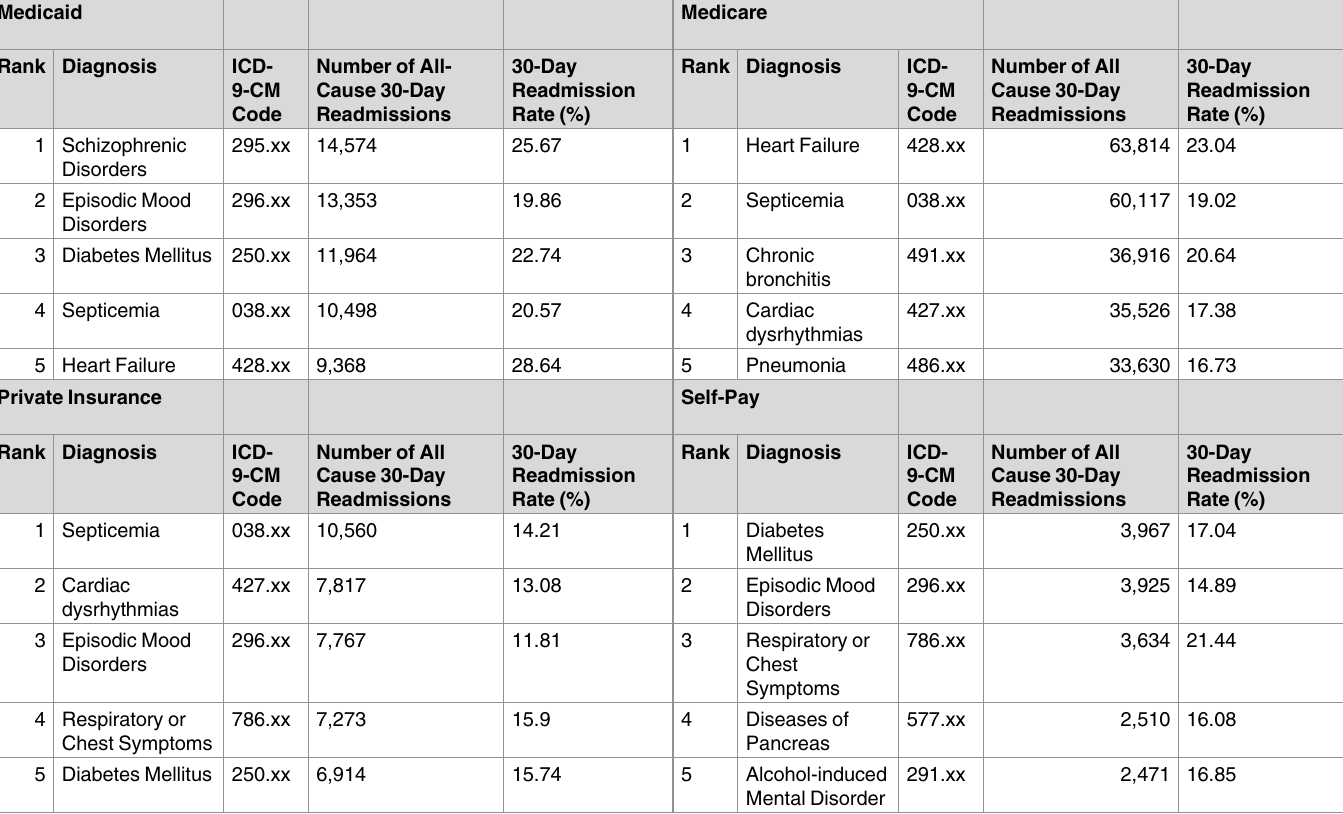
Table 3. Most common discharge diagnoses for the index admission for patients readmitted within 30 days stratified by payer and rates of readmission.